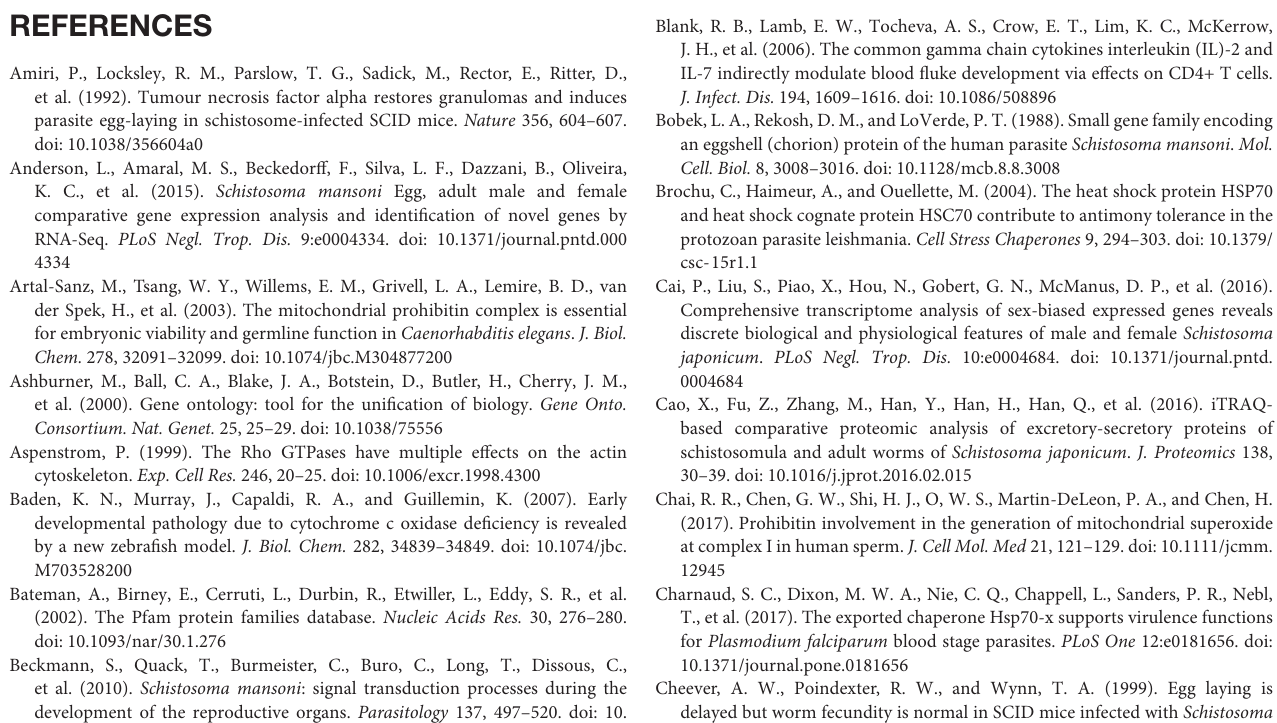
FIGURE S6 | Schematic overview of the experimental design of RNAi in vivo . All biological replicates of BALB/c mice infected with S. japonicum cercaria (n = 5 for each group - SjPhb1 dsRNA injection group, EGFP dsRNA injection group, and 0.7% NaCl injection group.) were maintained in the same conditions, except that they were received SjPhb1 dsRNA injection, EGFP dsRNA injection, and 0.7% NaCl injection through tail vein immediately after infection then given an additional injection every 5 days for up to 26 days, respectively. FIGURE S7 | Worm burden and pairing rate. (A) Comparison of the worm burden of the three groups. (B) Comparison of the pairing rates of the three groups. TABLE S1 | Purity and quantity of total RNA of the S. japonicum worms sample. TABLE S2 | Relative expression level of detected genes among samples. TABLE S3 | Differentially expressed mRNA for S_M vs B_M and their annotation. TABLE S4 | Differentially expressed mRNA for S_F vs B_F and their annotation. TABLE S5 | Primers used in qRT-PCR for differentially expressed mRNAs validation. TABLE S6 | Data of the expression fold changes of 35 DEGs measured by RNA-seq and qRT-PCR. TABLE S7 | GO enrichment analysis for differentially expressed mRNA between S_F vs B_F_ALL. GO enrichment analysis for differentially expressed mRNA between S_F vs B_F_top20.